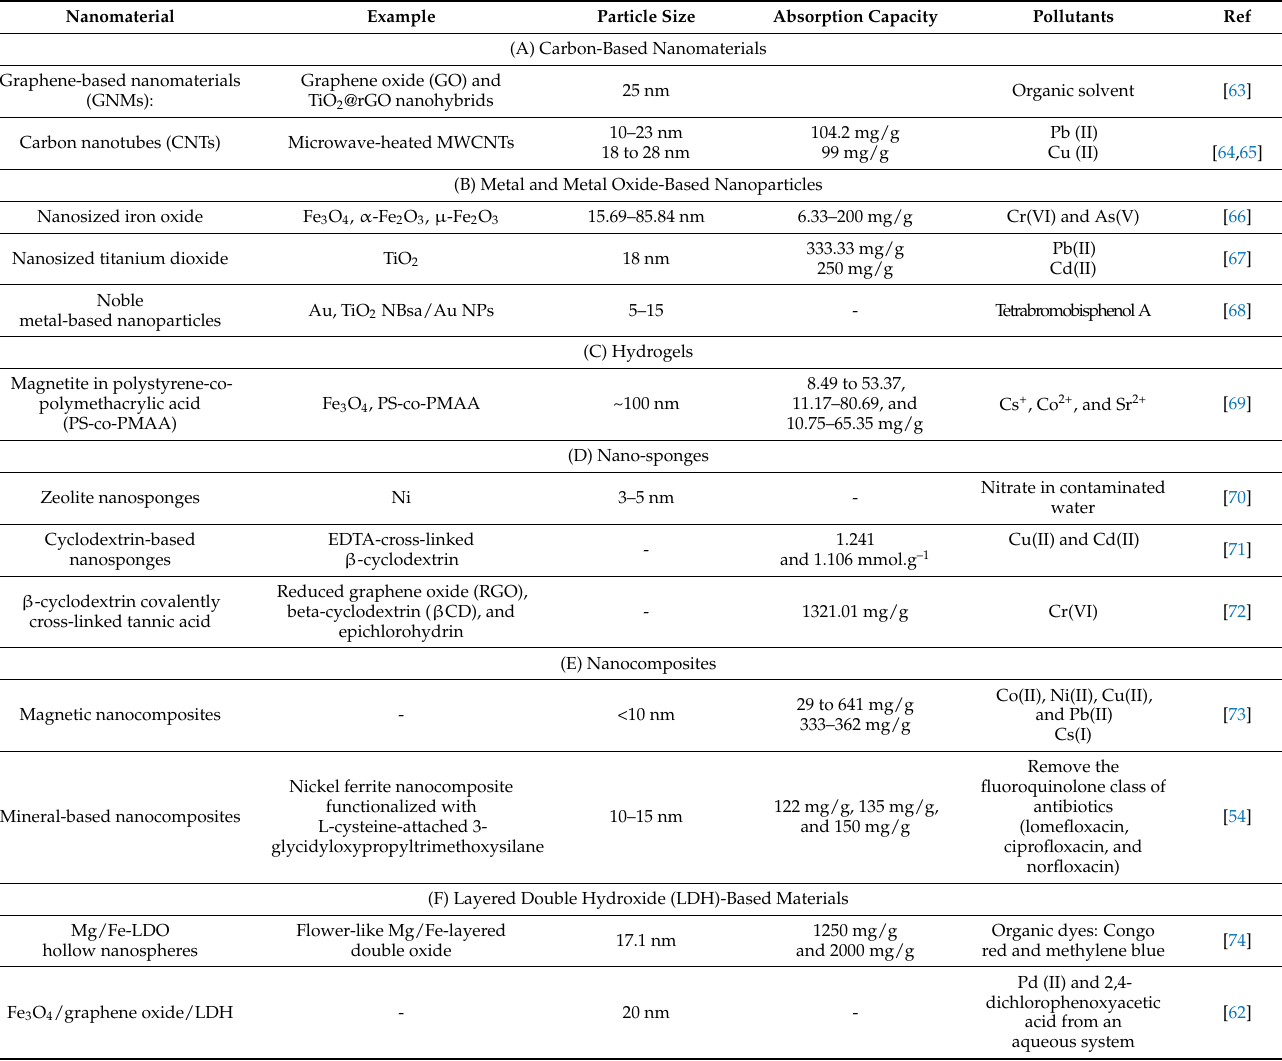
Table 1. Summary of nanoparticles used as adsorbents for water